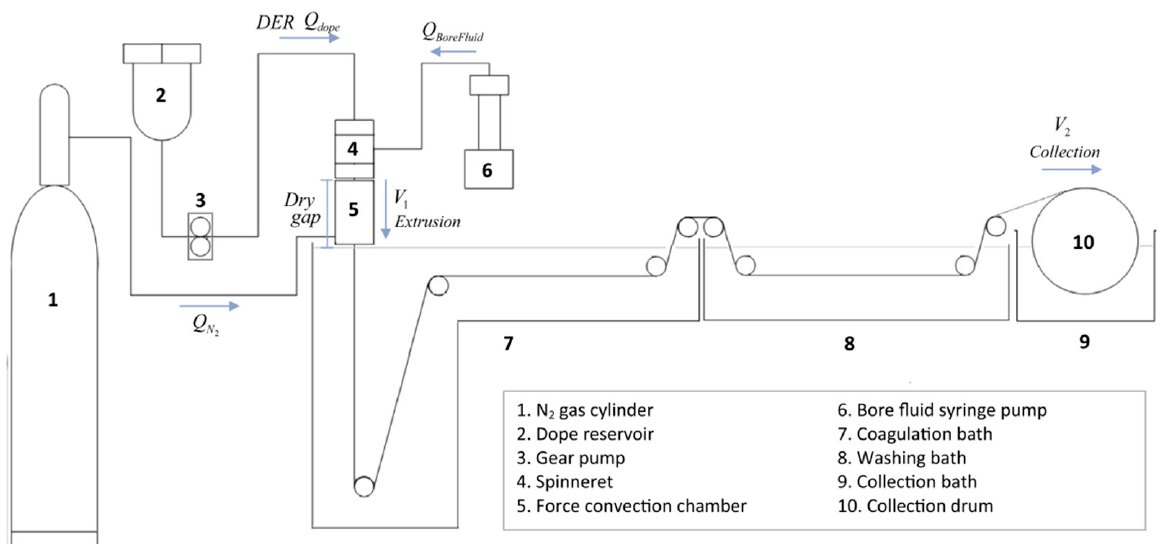
Figure 7. Schematic diagram for the spinning machine setup for the fabrication of hollow fiber mixed matrix membranes for gas separation [94].